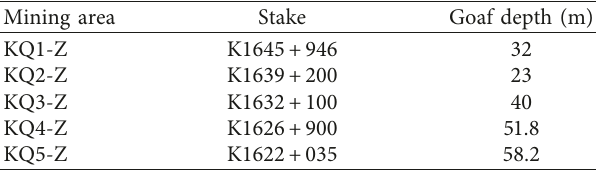
Table 2: The stake number of the monitoring point in the middle of the mining area and the depth of the goaf.